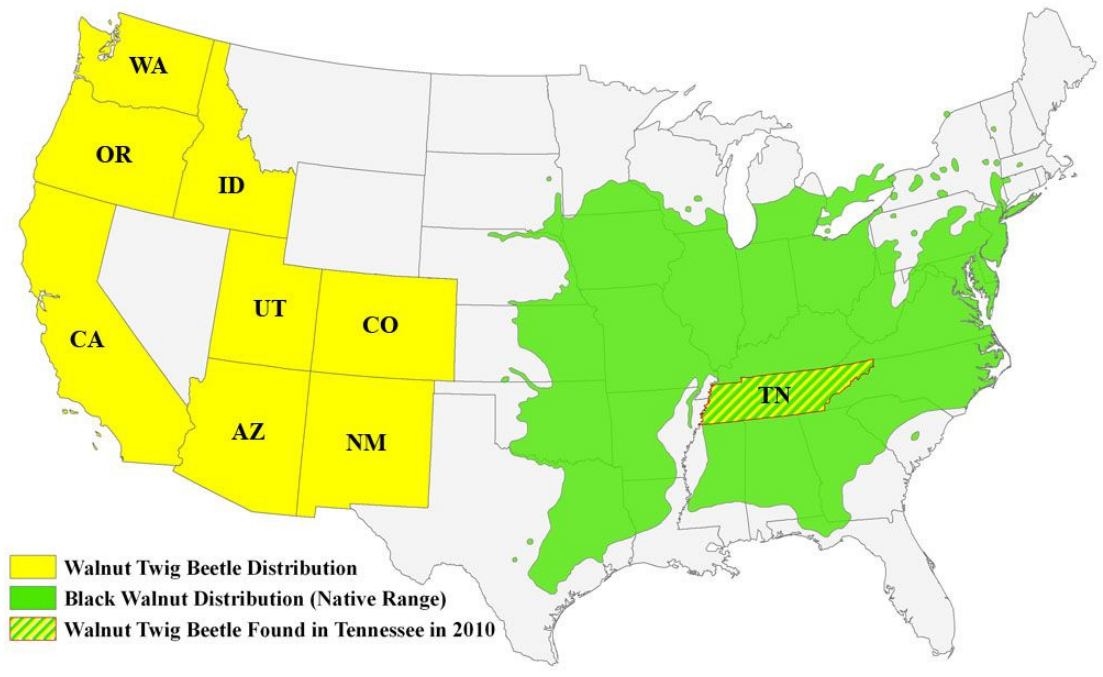
Figure 1. Native distribution of black walnut in North America (from U.S. Geological Survey tree distribution data [6]) and distribution of the walnut twig beetle in the U.S., 2010